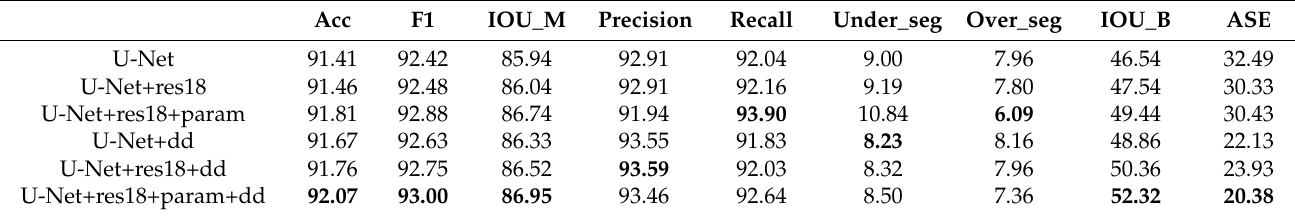
Table 2. Comparison among different U-Net based models. Pixel accuracy (Acc), F1 score, Intersection over Union for the ore mask (IOU_M), precision, recall, under-segmentation, over-segmentation, Intersection over Union for the ore boundary (IOU_B), and error of the average statistical ore particle size (ASE). The bold number means the best result. Acc F1 IOU_M Precision Recall Under_seg Over_seg IOU_B ASE U-Net